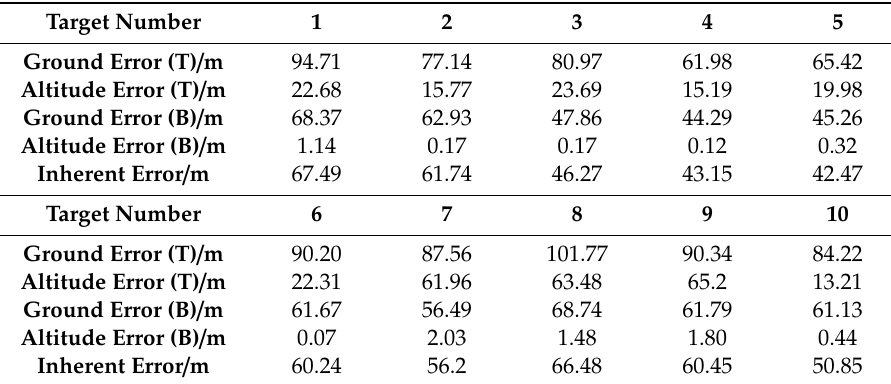
Table 5. Results of decomposition